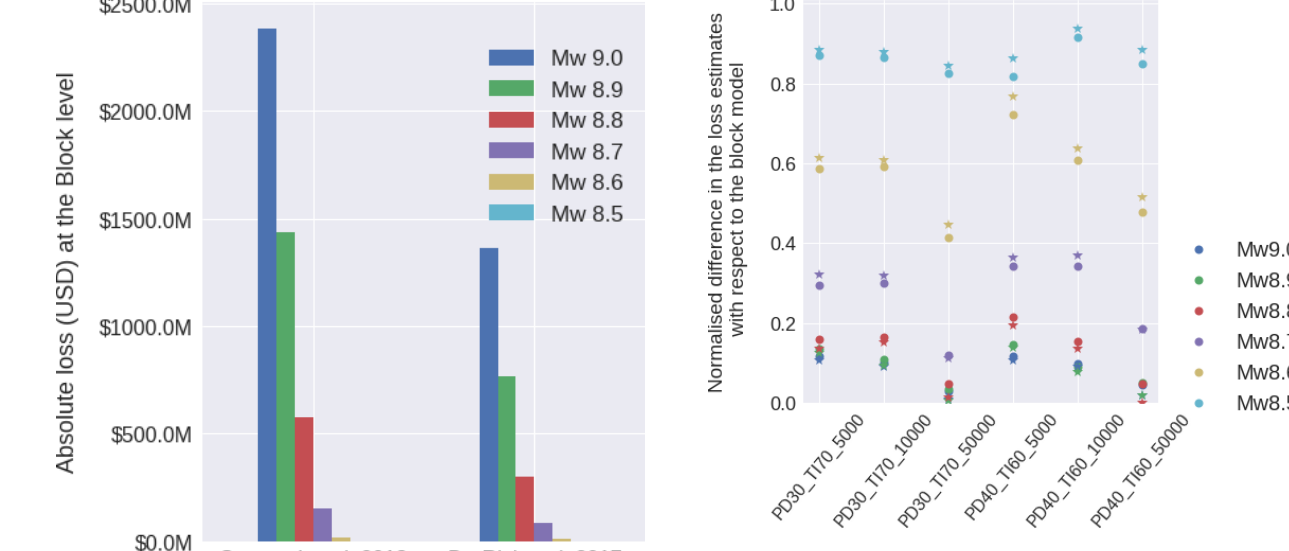
Figure 16. Discrepancy between the tsunami-induced losses be- tween each CVT-based model and the block model for the six sce- narios. The values obtained from the Suppasri et al. (2013) and De Risi et al. (2017) schemes are denoted by stars and circles respec-